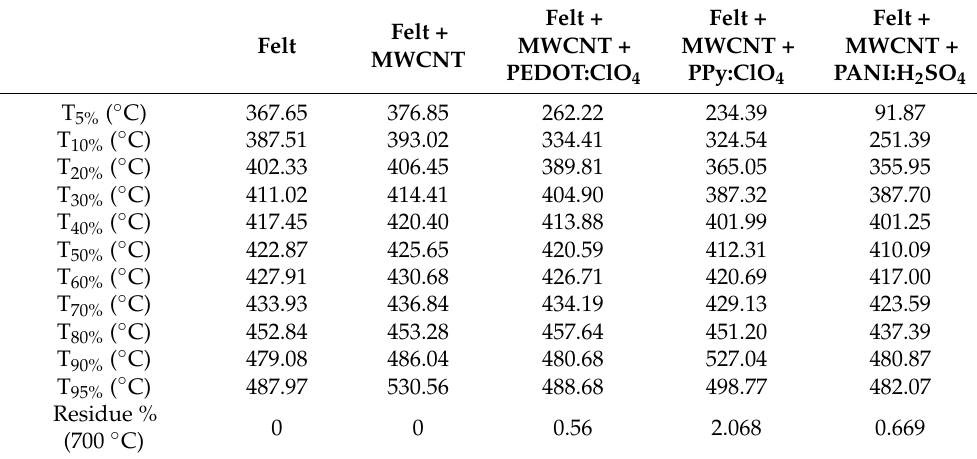
Table 2. Weight loss temperature at different percentages and residue percentages at 700 °C of